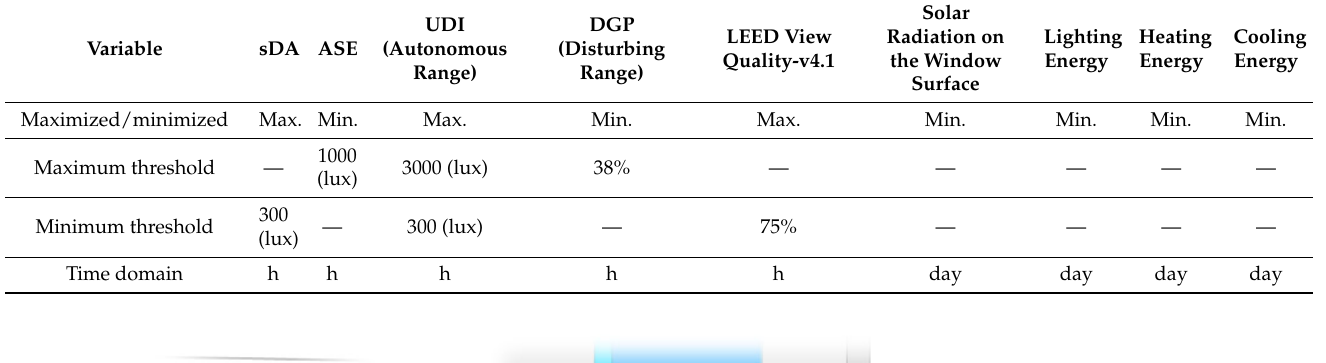
Table 2. The objective functions to be optimized.